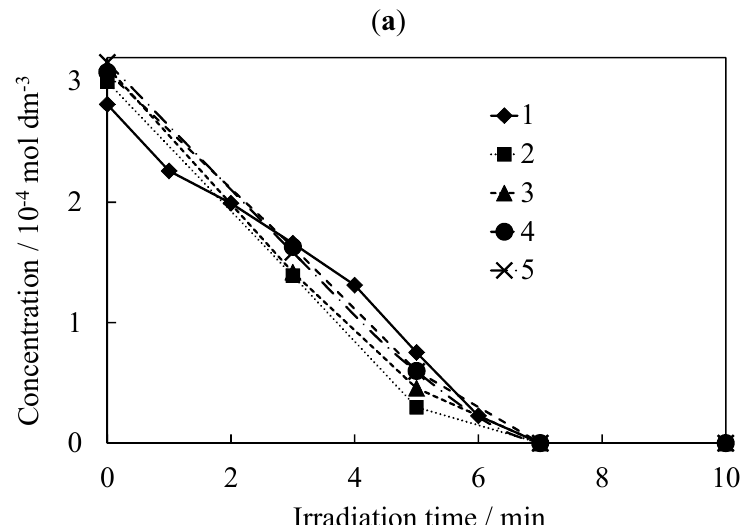
Figure 8. Time course of TCE concentration during the cycling of the photocatalytic degradation of TCE using Sample S400 during ( a ) UV or ( b ) visible irradiation. ( a